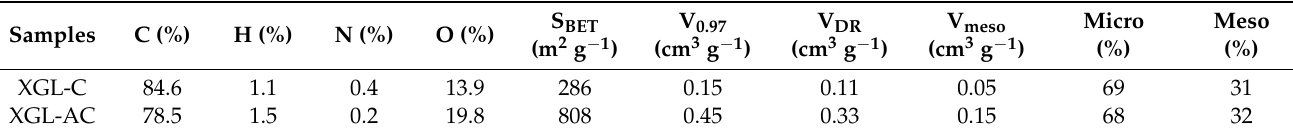
Table 3. Chemical composition and textural properties of xerogel-like materials.